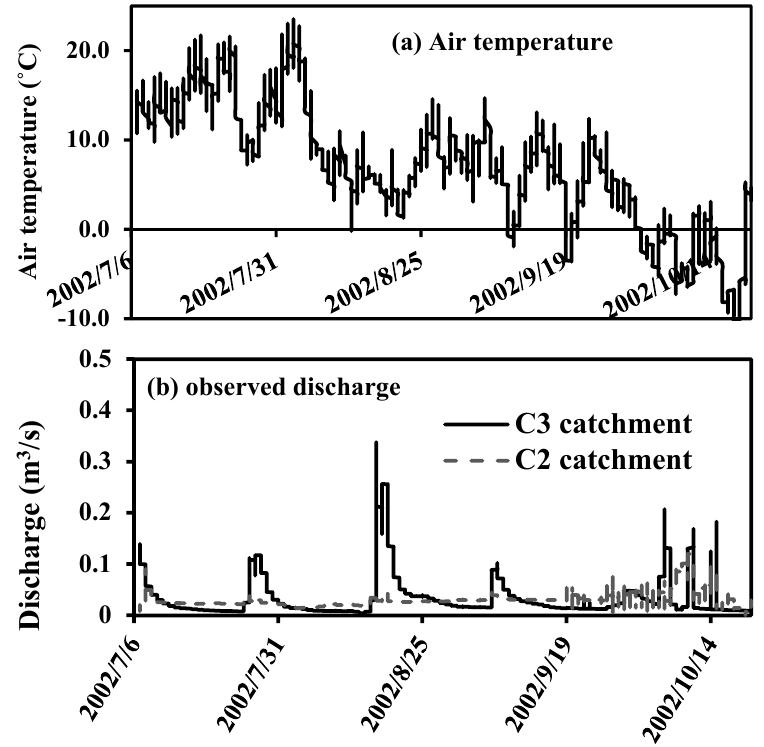
Figure 9. Caribou Poker Creek Research Watershed (CPCRW) ( a ) Observed discharge Observed discharge of C2 and C3 catchments, sub-catchments of CPCRW shown in Figure 1 ( b ) air temperature from Cpeak station shown in Figure 1.